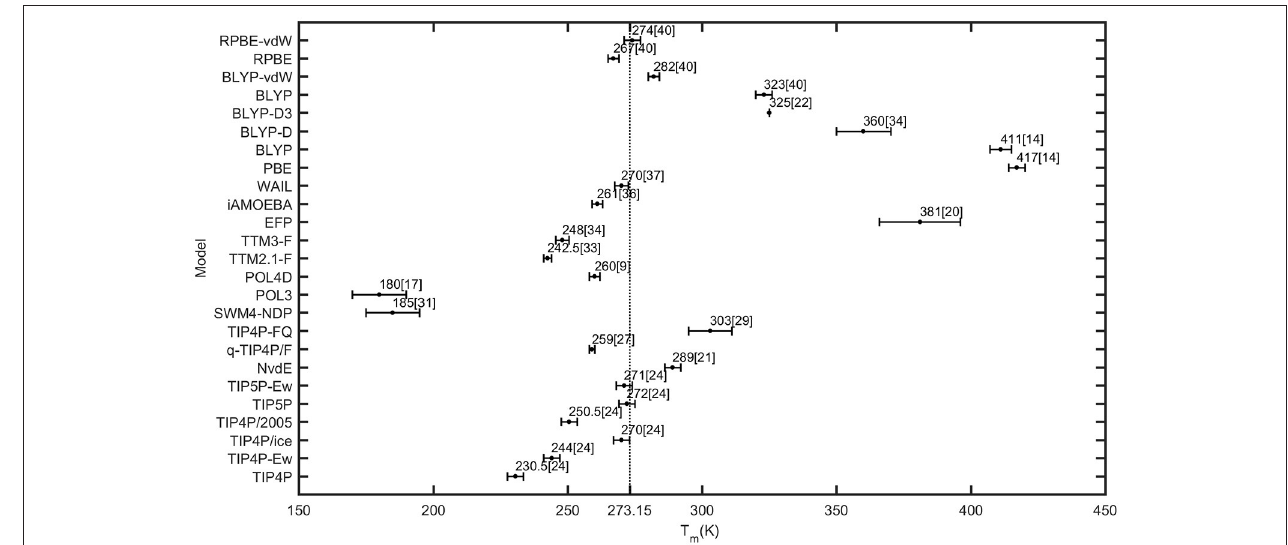
FIGURE 1 | Different melting temperatures of water within various